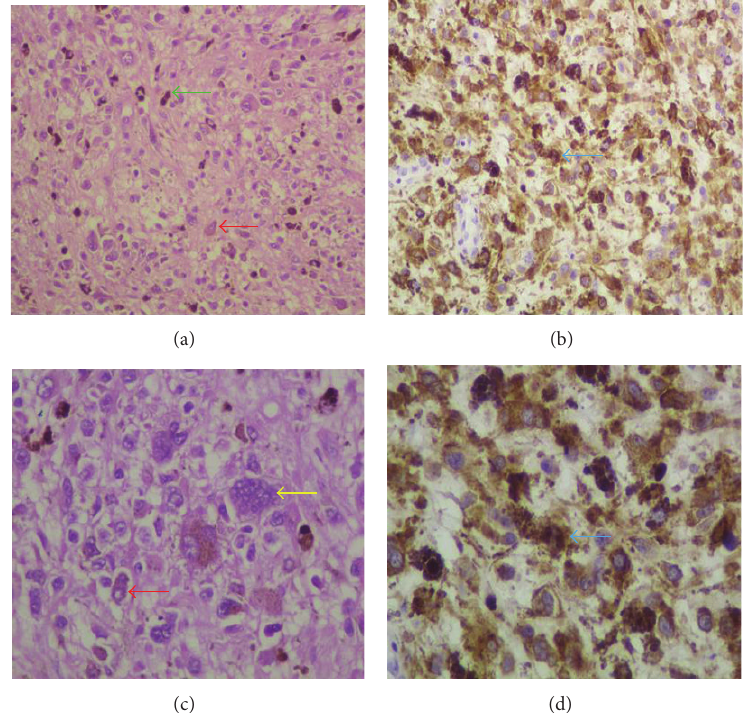
Figure 1: (a, b) Histologic details from tumor. The predominant cell type was epithelioid (red arrows) and not spindle cell. There were also multinuclear giant cells (yellow arrow) and abundant melanin deposition (green arrow) (H&E (a) × 200, (b) × 400). (c, d) Immunophenotype of tumor cells. The neoplastic cells expressed tyrosinase (blue arrows) (Streptavidin peroxidase (c) × 200, (d) ×